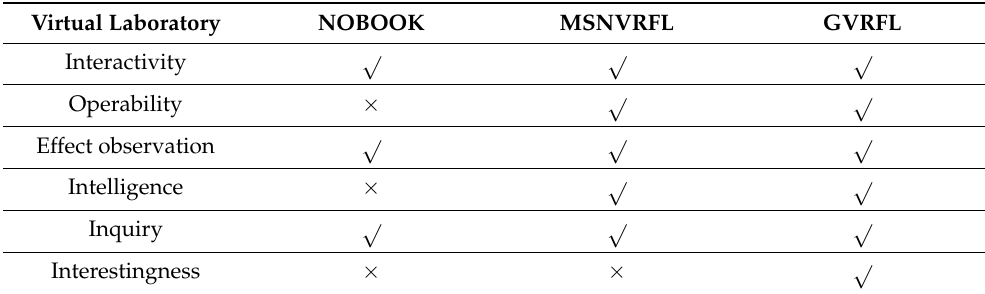
Table 2. Performance